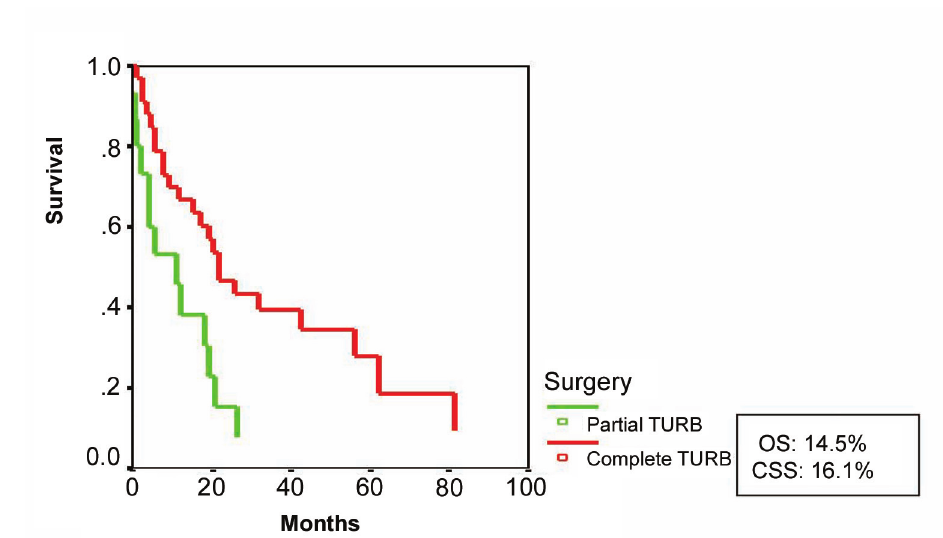
Figure 2 – Survival rates after partial or complete transurethral resection of bladder tumor (TURBT)